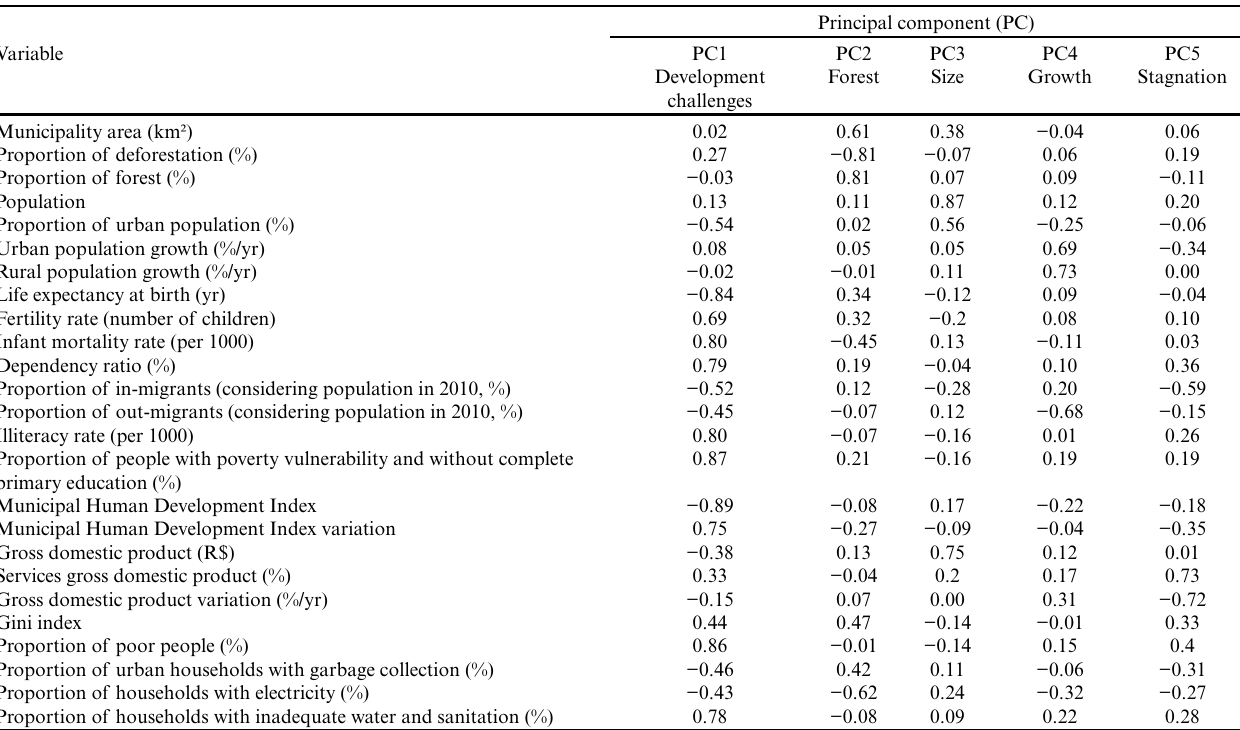
Table 3. Correlation matrix of the rotated components obtained via varimax rotation, Legal Amazonia, 2000–2010. Data sources: INPE (2014), IBGE (2000, 2010), and PNUD